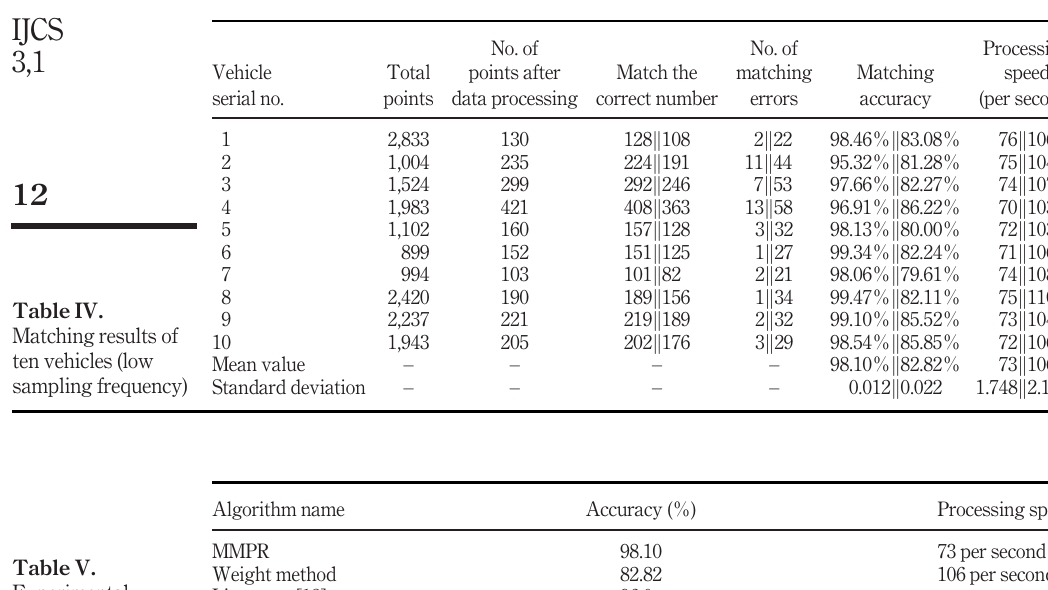
Table V. Experimental